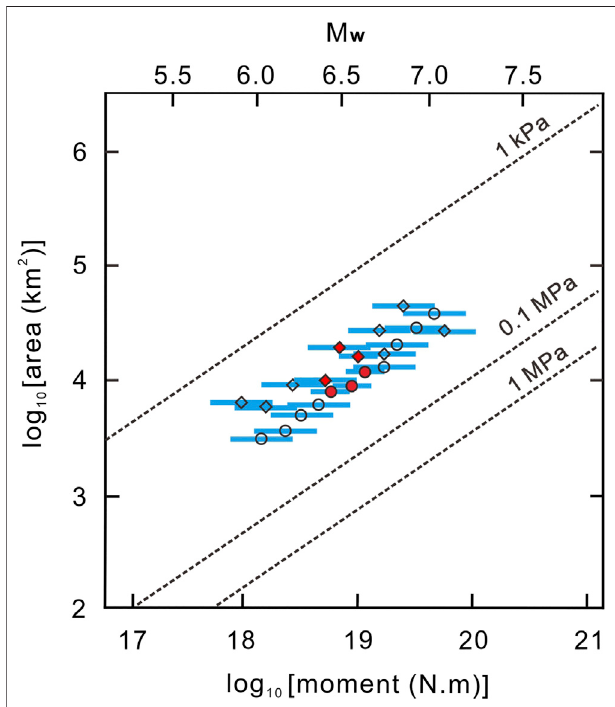
FIGURE 4 | Comparison between the shear stress and normal stress changes of the observed and synthetic SSEs estimated from Figure 2 . The circlesanddiamondsrepresenttheshearstressandnormalstresschangesof SSEs,respectively, averagedover theentirefault regionin Figure 1 .The dotted isolines of the stress decrease are derived from the empirical circular crack